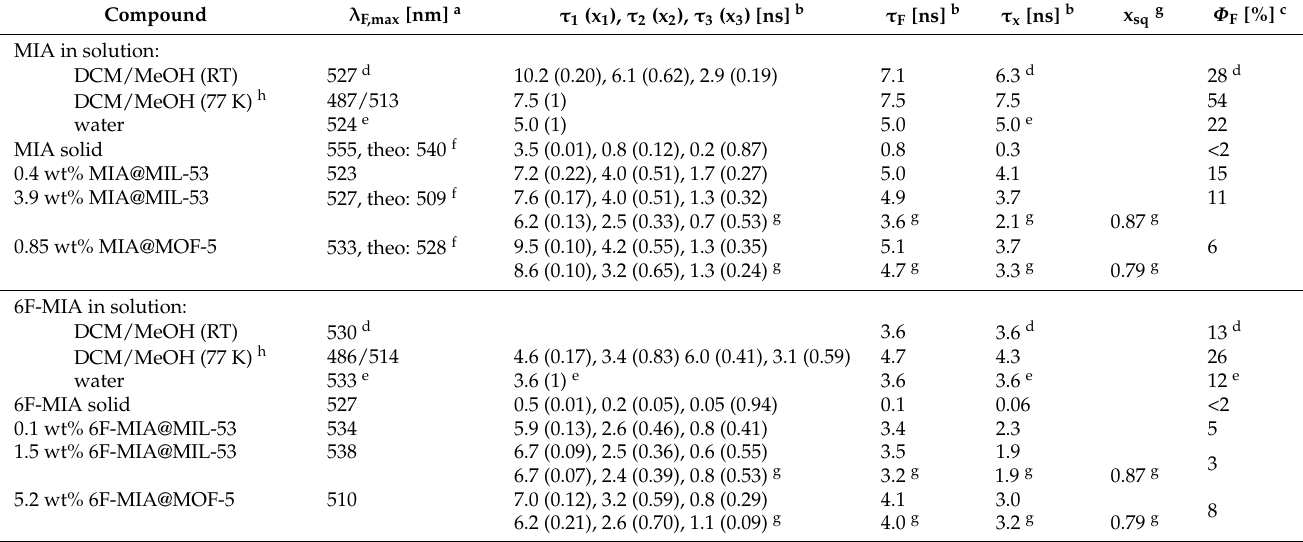
Table 3. Photophysical data for MIA, 6F-MIA and the flavin@MOF composites with λ exc = 405